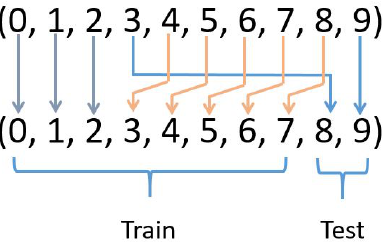
Figure 7. How to rearrange class labels in order to have a different Unk class and generalize the experiment.